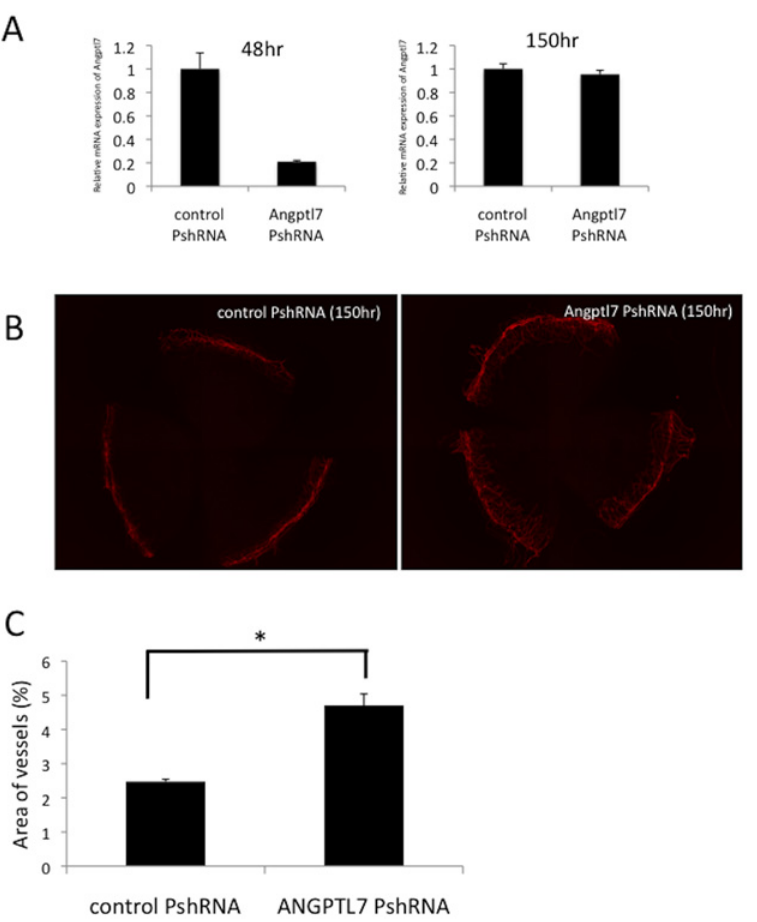
Figure 5. Blood vessel growth on the avascular corneas of mice after suppression of gene expression by using an ANGPTL7 PshRNA. ANGPTL7 mRNA expression was inhibited by almost 80% inhibition at 48 h after intrastomal injection of the ANGPTL7 PshRNA, but normal expression was restored by 150 h (A, n = 3 per condition). The corneas of mice injected intrastromally with the control PshRNA did not exhibit any expression change (B, left panel). Notably, intrastromal injection of the ANGPTL7 PshRNA resulted in the spontaneous development of blood vessel growth from the limbal areas in the avascular mouse corneas by day 4 after the injection (B, right panel). Areas of vessels in the mouse corneas were significantly different following the injection of control PshRNA injection and ANGPTL7 PshRNA injection ( p < 0.001, C, n = 4 per